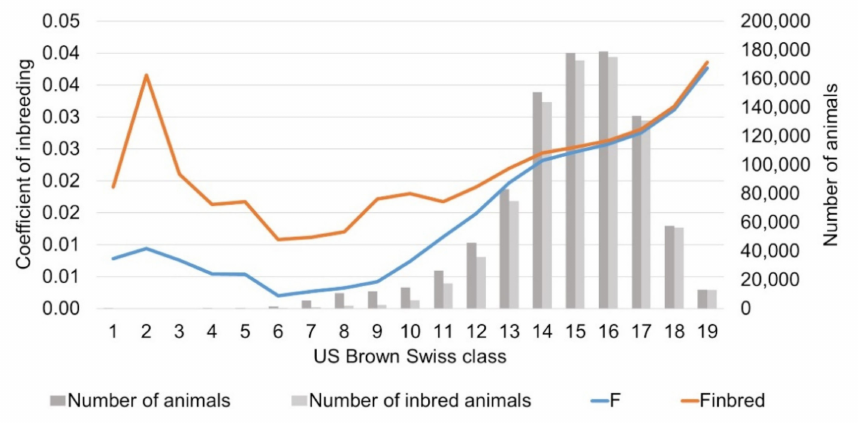
Figure 5. Number of German Brown and inbred German Brown and coefficient of inbreeding for all (F) and inbred (F inbred ) German Brown by breed proportions of US Brown Swiss in classes of